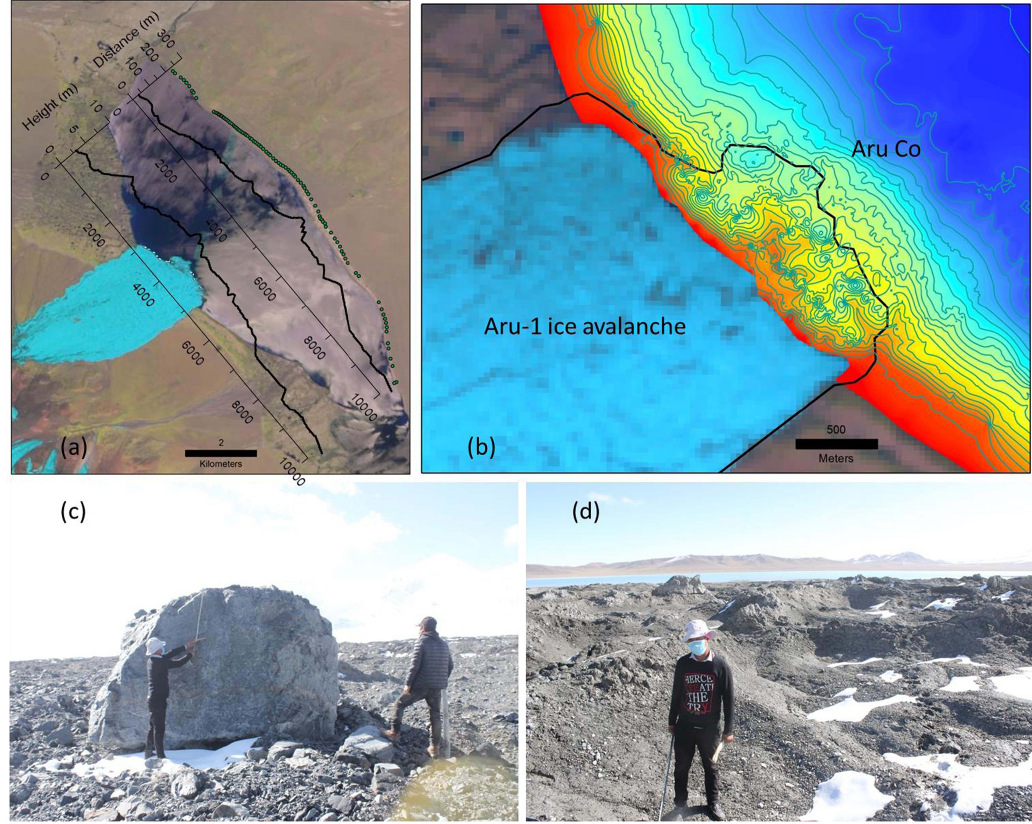
Figure 3. The impact of the Aru-1 glacier collapse on the morphology of Aru Co. (a) The extent of the Aru-1 ice avalanche (Sentinel-2 image on 21 July 2016) and the impact wave at the opposite shore of Aru Co (green dots). The two curves describe the footprint of the impact wave along the eastern shoreline of Aru Co, including the distance to shoreline and the relative height to Aru Co’s surface. (b) The uneven lake bathymetry at Aru Co near the Aru-1 ice avalanche. The black line indicates the extent of the intruding ice into Aru Co on 21 July 2016. (c, d) A large amount of debris left after the fragmented ice mass melting (photos taken on 3 October 2019 by Yanbin Lei). Table 1. Ice avalanche melting and its contribution to lake level increase at Memar Co between 2016 and 2019.